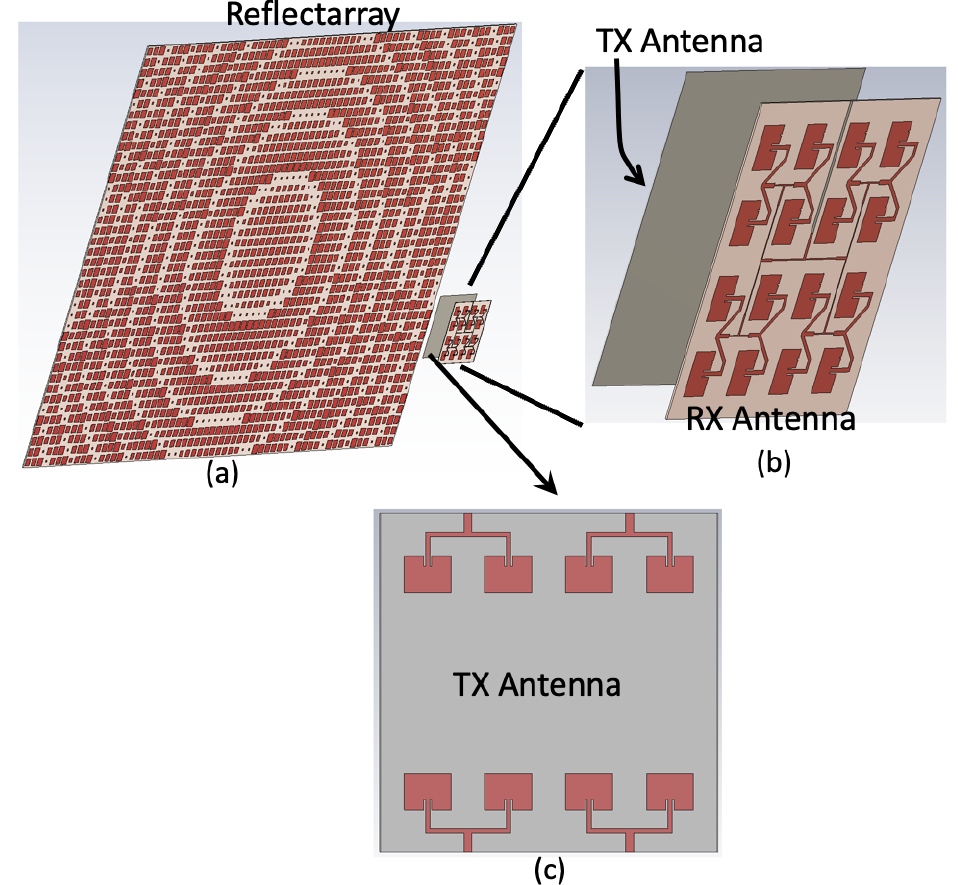
Figure 2. ( a ) The reflectarray fed with the novel TX and RX antenna assembly, where the TX and RX are placed back-to-back. ( b ) The RX antenna board is a 4 × 4 array, and ( c ) TX antenna is four 1 × 2 array antennas facing the